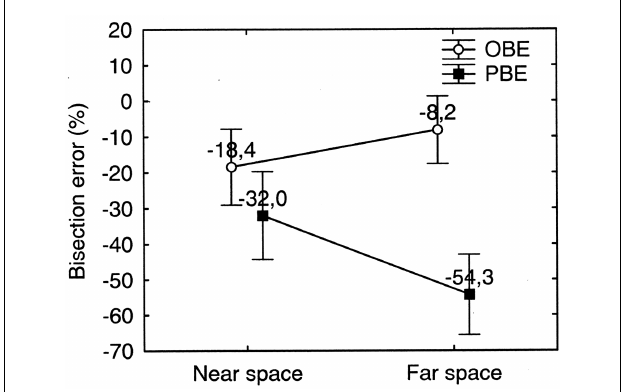
FIGURE 8 | Graphic representation of the occurrence of prismatic adaptation (PA) in patient MR during each treatment session (session 1–4) . Positive and negative values indicate deviations to the right and to the left of the target, respectively. Adaptation occurs if the rightward pointing error measured at the end of the adaptation procedure (End: pointing movements no. 113–120) is significantly smaller than the error measured at the beginning of the adaptation procedure (Beginning: pointing movements no. 1–8). Error reduction is significant in every treatment session except in session no. 2. See text for